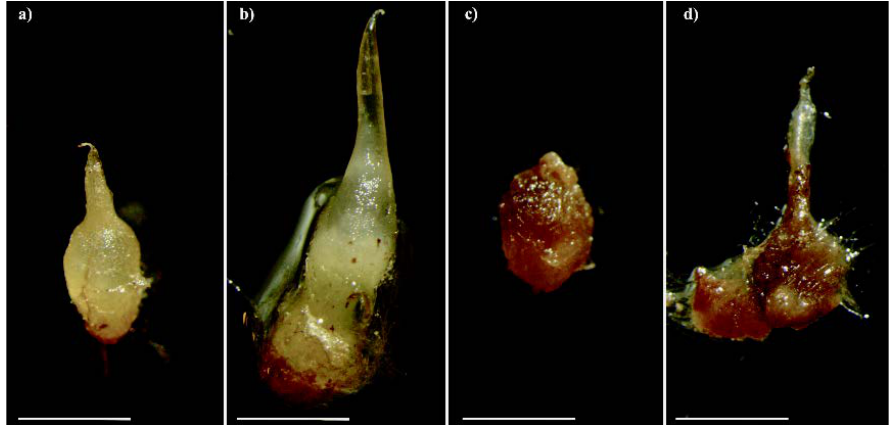
Figure 1. Protocorms of Serapias vomeracea inoculated with Tulasnella calospora at different stages: